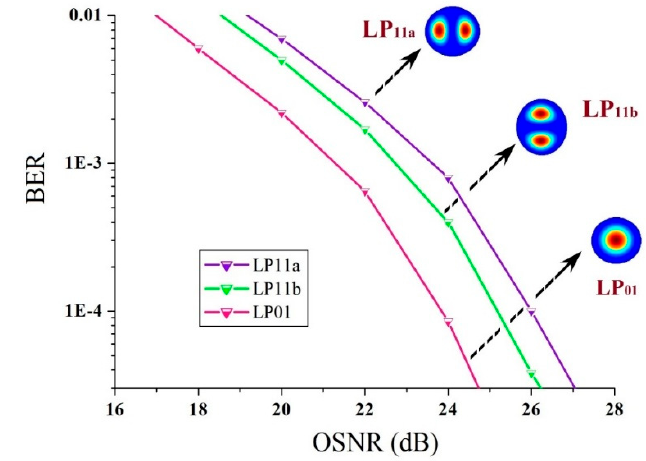
Figure 23. The BER vs. OSNR for three different modes for a PDM-64QAM signal using the STBC-RLS scheme [27].